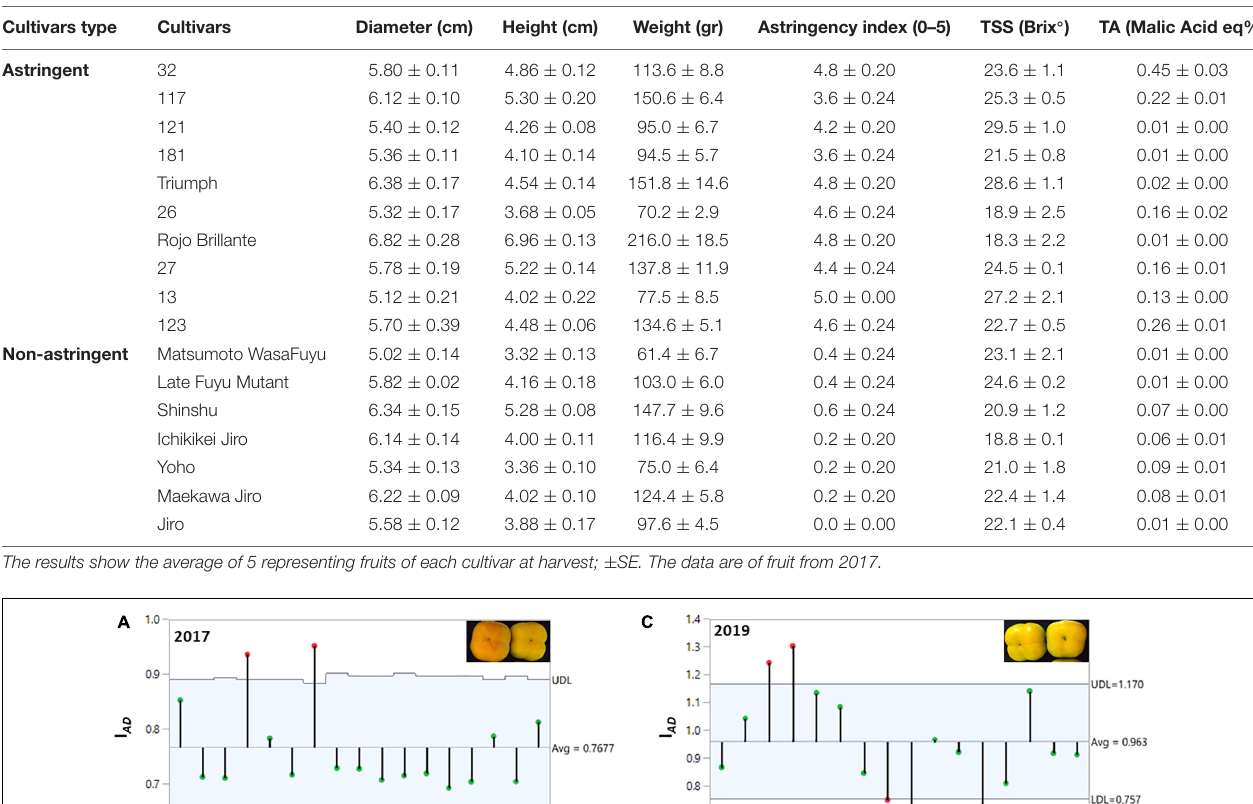
TABLE 1 | Size, astringency, TSS, and TA of persimmon cultivars fruit at harvest. Cultivars type